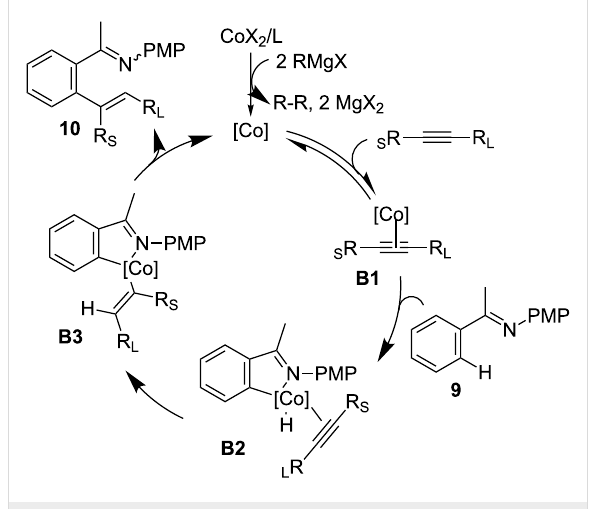
Scheme 9: A plausible pathway for Co-catalyzed hydroarylation of